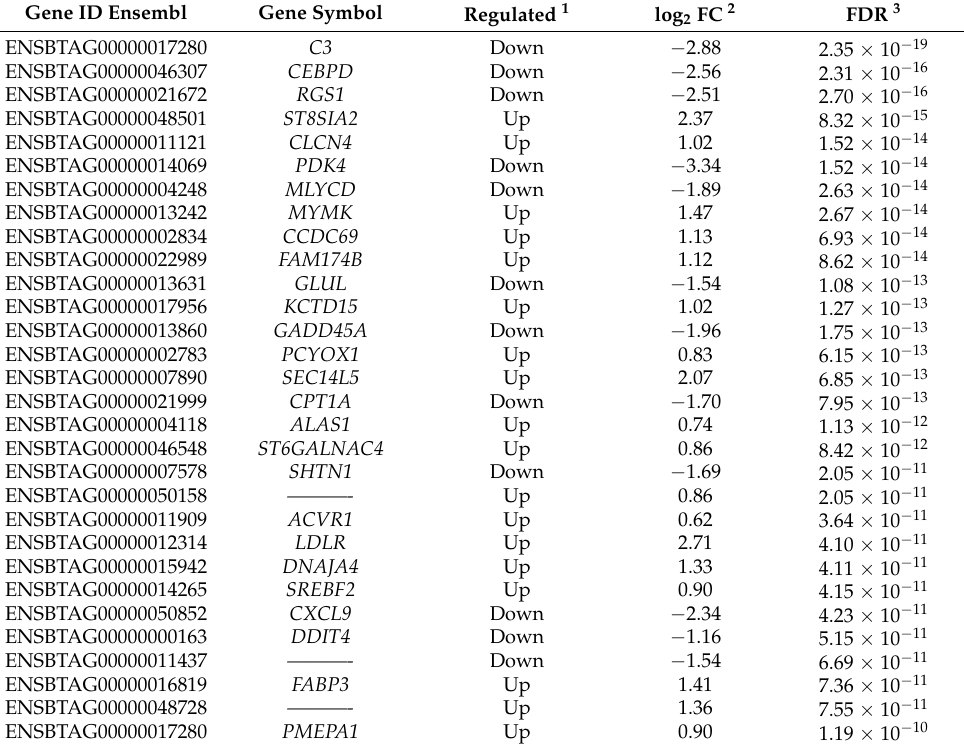
Table 5. Top 30 genes identified as differentially expressed between G1 (no creep feeding) × G2 (creep feeding) at weaning.